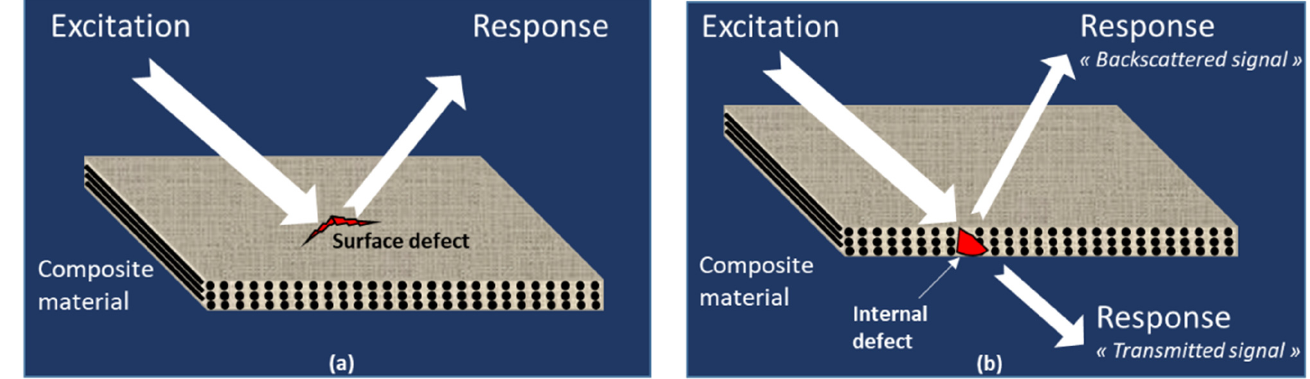
Figure 1. Non-destructive techniques principles: ( a ) surface techniques, ( b ) volume techniques.